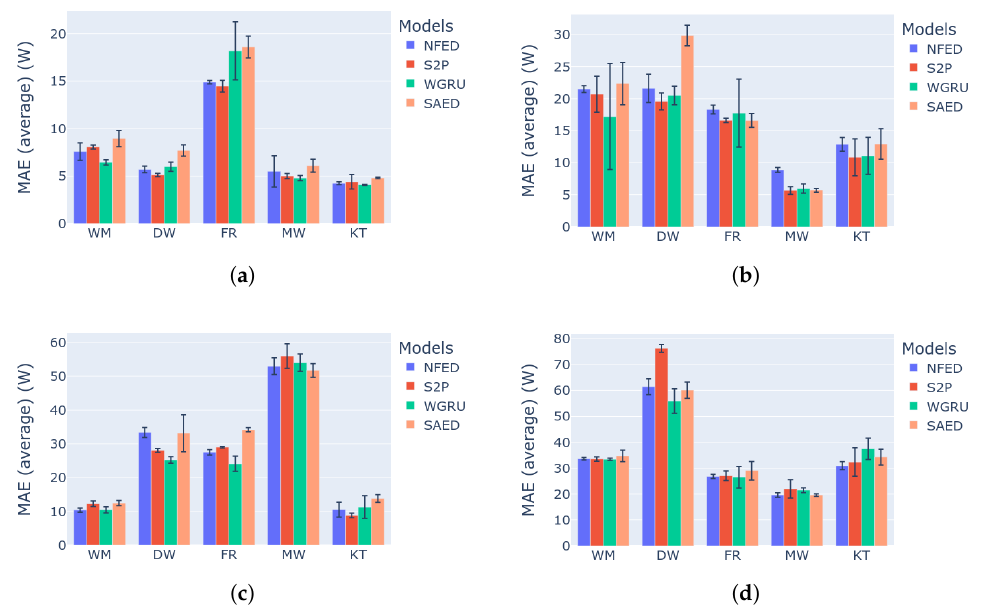
Figure 8. Benchmark categories 1–2 results for the models NFED, S2P, WGRU and SAED: ( a ) category 1: MAE results; ( b ) category 2: MAE results. Benchmark categories 3–4 results for the models NFED, S2P, WGRU and SAED: ( c ) category 3: MAE results; ( d ) category 4: MAE